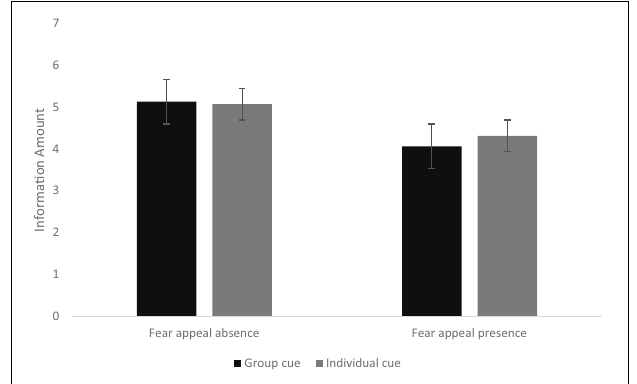
FIGURE 2 | The interaction effect of social norm appeals (individual vs. group cues) and fear appeals (absence vs. presence) on information believability.